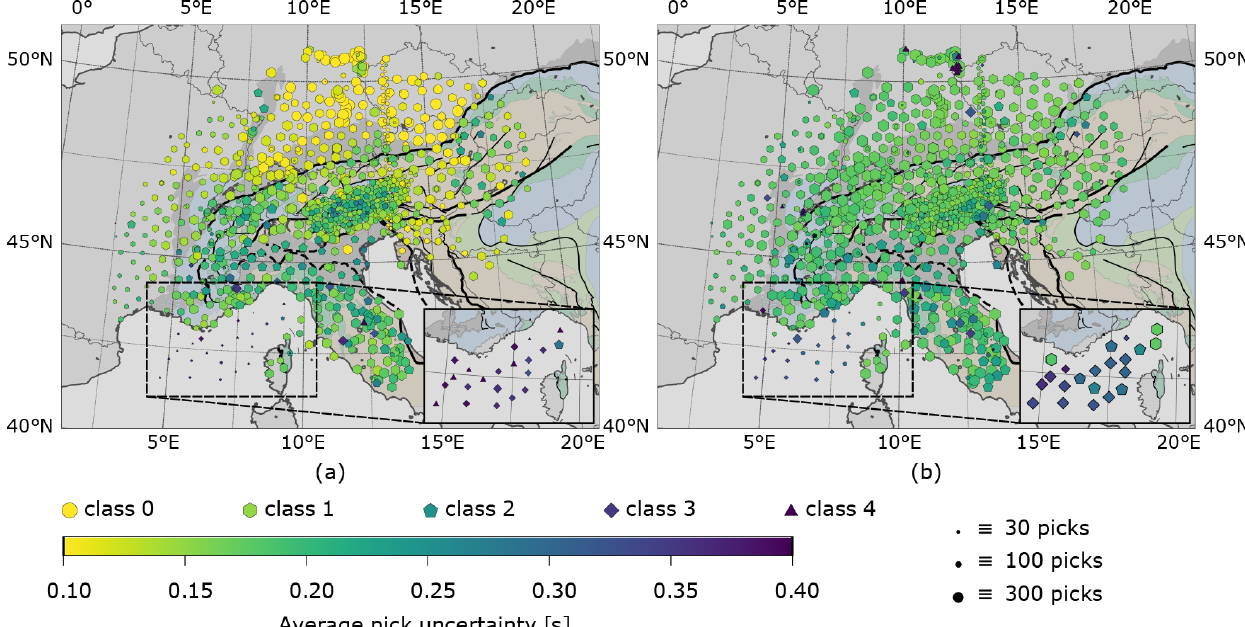
Figure 7. Maps of the median uncertainty of all picks for the high-frequency (a) and the low-frequency (b) dataset. Symbol sizes correlate with number of picks per station, colour shows the average travel-time uncertainty and symbol shapes indicate the average pick class on each station. Inset shows OBS stations only with symbol size increased by a factor of 2.5. Travel-time uncertainty gets higher for db 0 . 5 in areas strongly influenced by deep subsurface structures, e.g. orogenic roots as well as strong heterogeneities close to the surface. Coverage in terms of measurement duration is best in the northern Alpine foreland, central Alps and Apennines. Complementary experiments are salient, as their measuring duration (i.e. number of total picks) is limited in contrast to other stations. The EASI experiment can be seen as a straight line of smaller-sized symbols on a north–south-directed profile, spatially (but with no overlap in time) cutting through the SWATH-D experiment in the central Alps above the Tauern Window. The latter has a higher station density compared to the rest of the array. Ocean bottom seismometers are characterised by a lower number of picks (smaller symbol size) as well as by a higher average uncertainty as a consequence of their noisy measuring